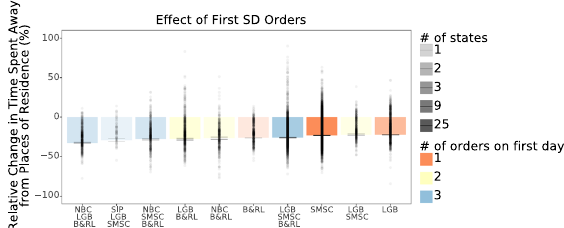
Fig. 4 Association between different combinations of fi rst social distancing orders on average time spent away from places of residence among 2810 counties in 50 US states and Washington, DC. Note that only two combinations of measures are observed in more than three states. Each bar re fl ects the average change (and 95% con fi dence interval) as estimated from a multivariable regression model. LGB large gathering ban, SMSC state-mandated school closures, B&RL bar and restaurant limits, NBC nonessential business